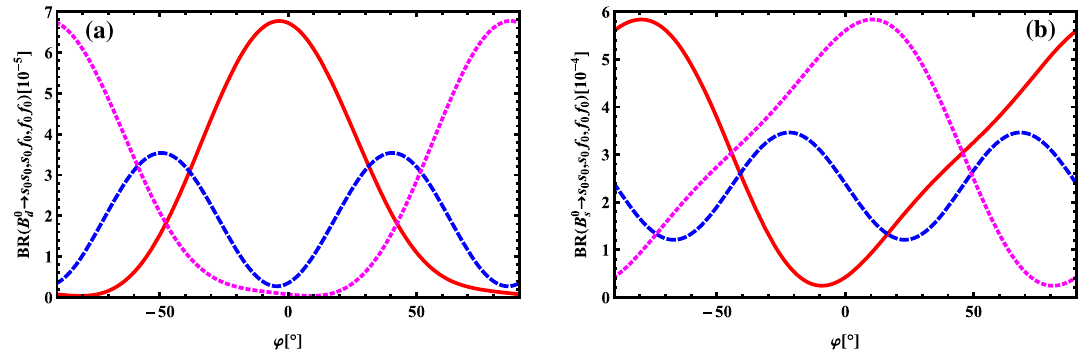
→ σσ,σ f , f ϕ in the PQCD approach, in which the red-solid line, the 0 0 f 0 branching ratios on d , s